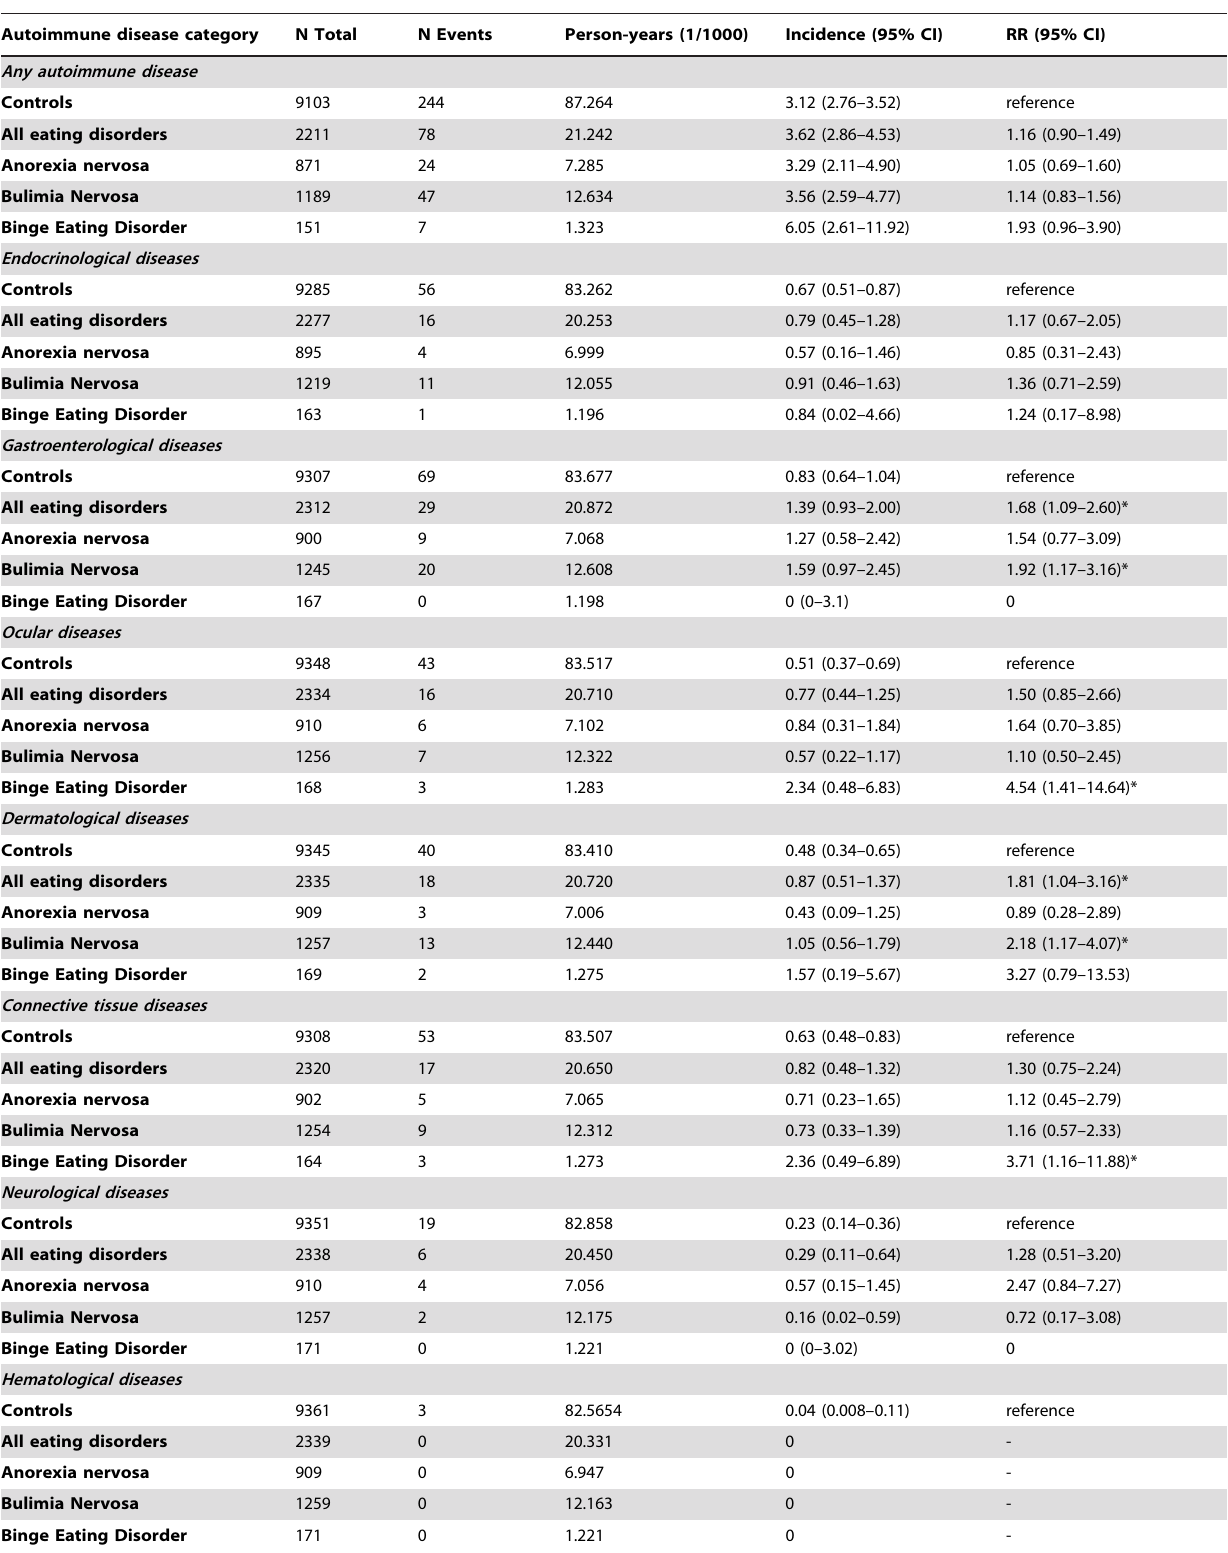
Table 3. Incidence of new onset autoimmune diseases after the start of the treatment for an eating disorder until the end of the study